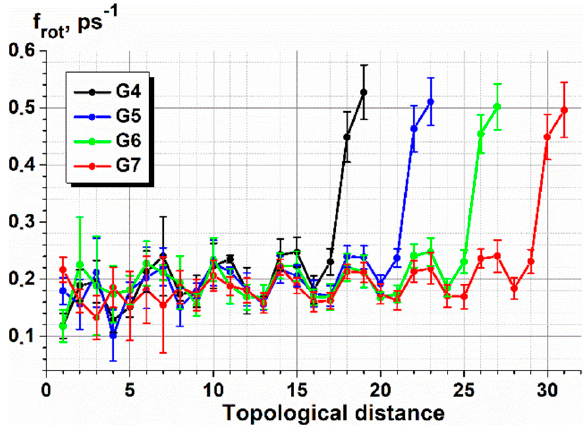
Figure 10. The average frequency of the transitions between the trans and gauche conformations vs. the number bonds (calculated from the core Si atom) for the c3-dendrimers of various generation numbers at 300 K.